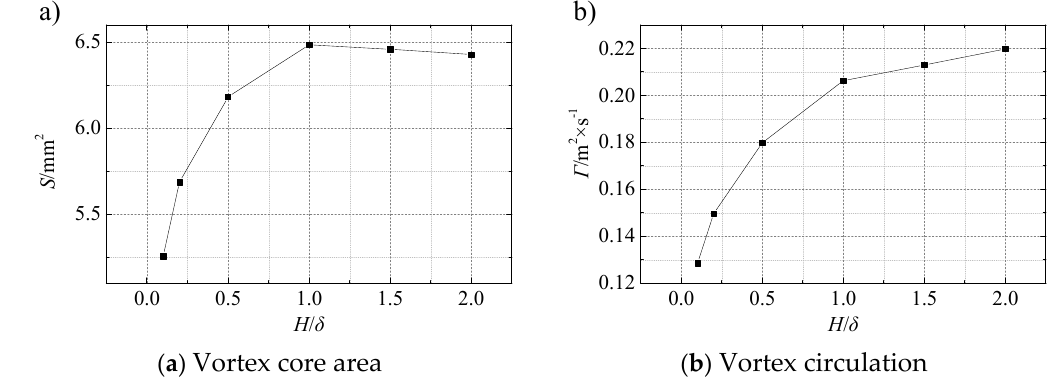
Figure 13. Change in vortex core area and vortex circulation at the VG trailing edge.